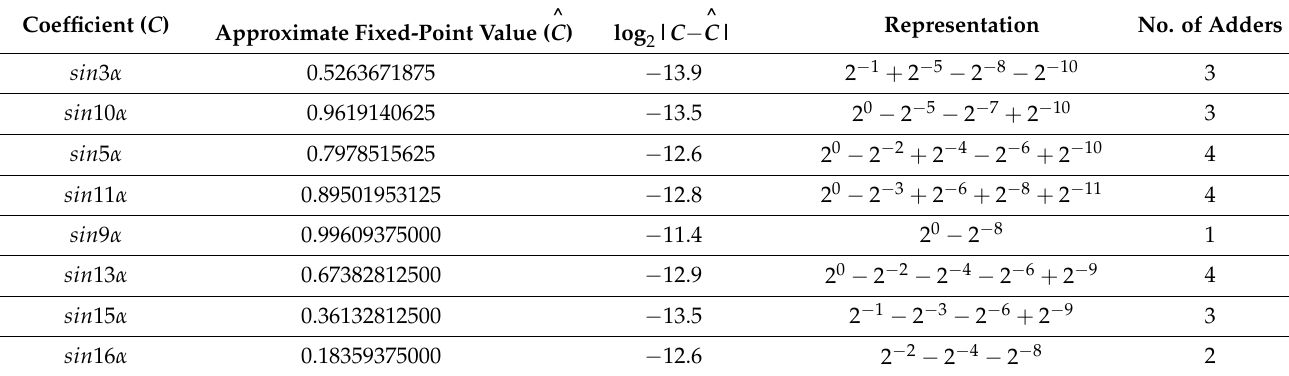
Table 1. Transform coefficients fixed-point approximation and their representations.